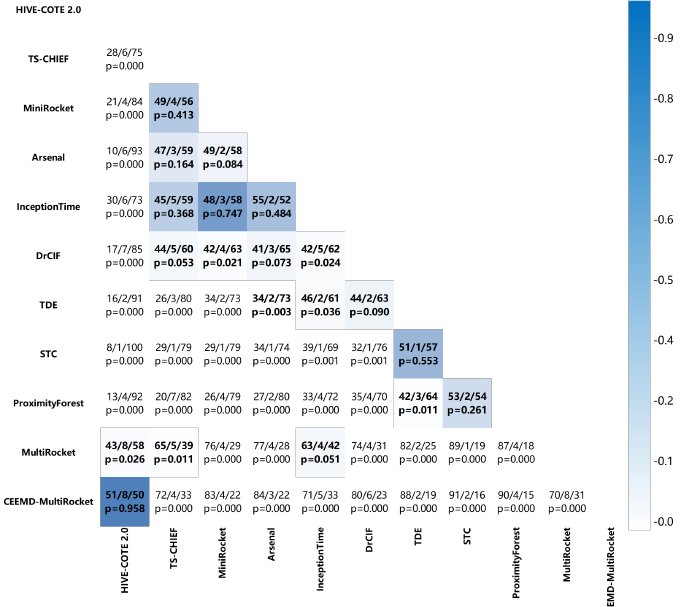
Figure 4. Pairwise difference between CEEMD-MultiRocket and 10 other SOTA algorithms in terms of statistical significance.